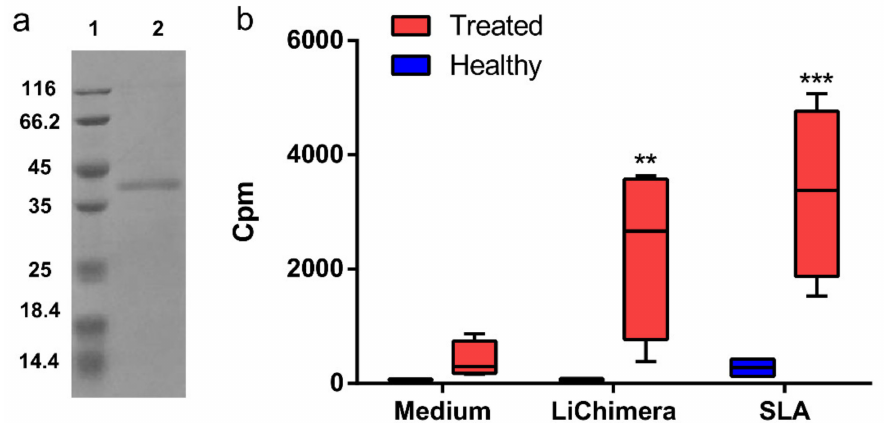
Figure 3. Recombinant LiChimera is antigenic in canine peripheral blood mononuclear cells (PBMCs) from Leishmania infected dogs. ( a ) The gene from LiChimera was cloned into pET-30a( + ) plasmid and overexpressed in E. coli BL21 by isopropyl- β -D-thiogalactopyranoside (IPTG) induction. The recombinant protein was purified by Ni-NTA chromatography, residual endotoxins were removed, and purity was confirmed by SDS-PAGE. Lane 1, molecular weight marker and lane 2, LiChimera; ( b ) PBMCs were isolated from healthy dogs ( n = 5) and cured from Leishmania infected dogs ( n = 5). PBMCs were stimulated with medium, LiChimera (10 µ g / mL), or soluble Leishmania antigen (SLA) (10 µ g / mL) for 96 h. Antigen-specific proliferation was determined by [ 3 H]-thymidine incorporation after another 18 h of culture and expressed as counts per minute (cpm). Bounds of box and whisker plots represent the min-to-max fraction of cpm. The line represents the median, the whiskers show the data range, and the box shows the interquartile range. Significant di ff erences between groups are indicated with asterisks measured by one-way ANOVA and Tukey’s multiple comparison tests. ** p < 0.01 and *** p <